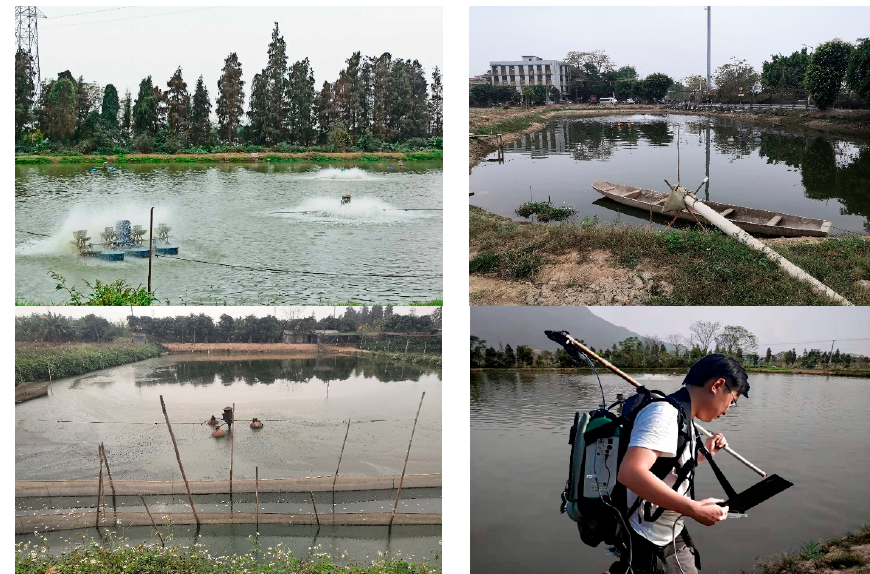
Figure 3. Photos of field investigations for the collection of ponds’ spectral information. The photos were taken by the authors.